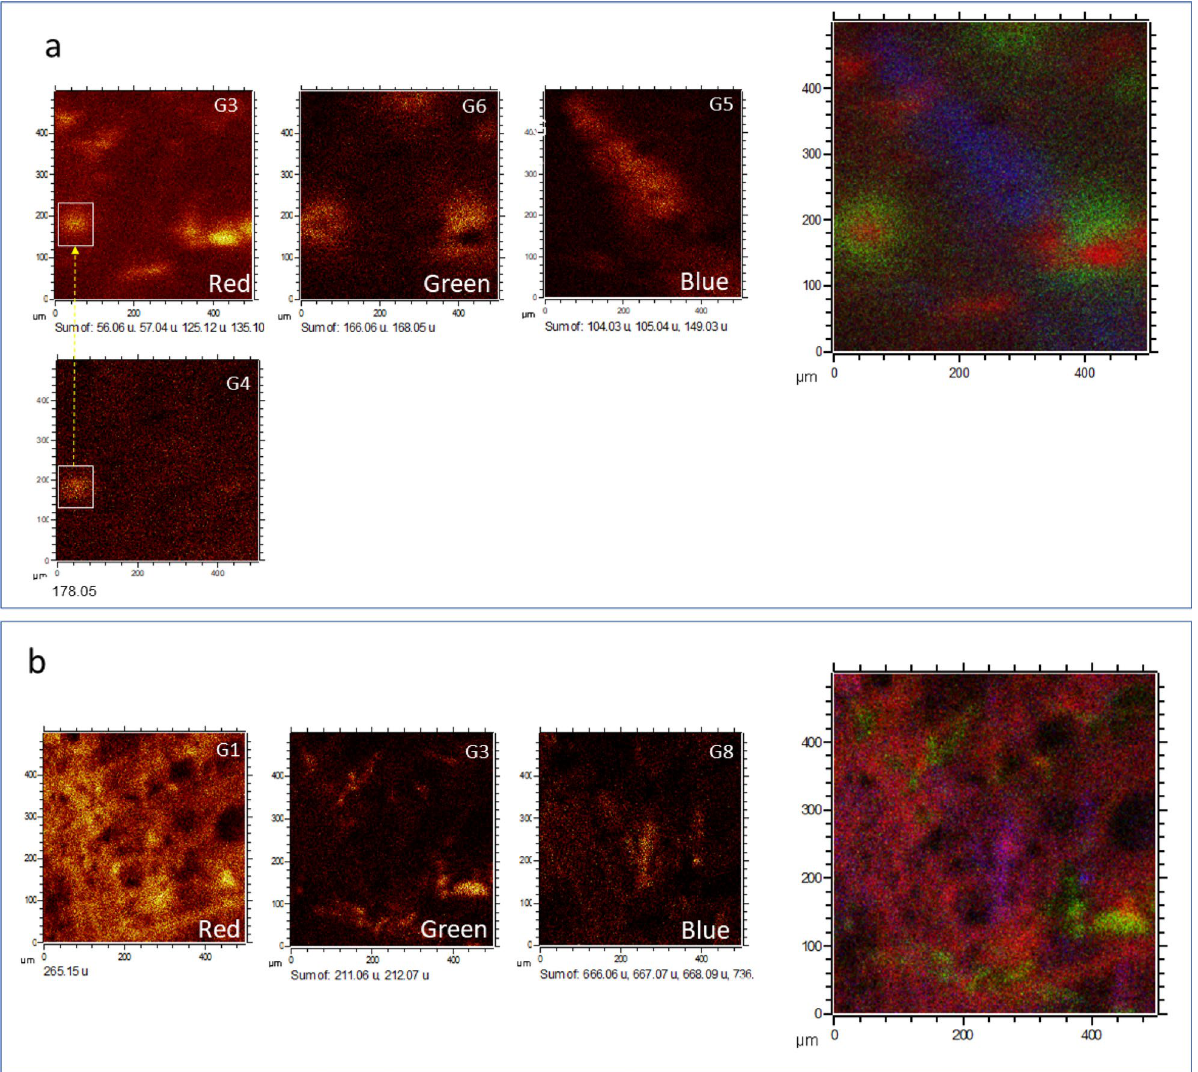
Figure 5. Couple of ToF–SIMS red/green/blue (RGB) overlays for ( a ) G3, G6 and G5 and ( b ) G1, G3, and G8 resulting in two different microstructure associations. The first RGB association ( a ) could correspond to compositional variations in plants (G5, G6, and G3) or to plant fragments (G5, and G6) affected by microbial activity (G3). Interestingly, G4 appears as a compositional variation in the G3 structure. The second RGB association ( b ) could include three different groups, namely, G1, G3 and G8 that could correspond to a microbial structure such as a biofilm in which the biomass is dominated by microbial forms biomineralizing sulfate. G3 structures interlock empty complementary areas in G1, suggesting that these areas could be the remains of different biological entities, while G8 branched microstructures merge with some filamentous units in G1, suggesting compositional variations in some specific zones of the filamentous mass of (Figs. S2–S4). By combining all the data sources retrieved via ToF–SIMS, the following morphological groups could be identified (Figs. 4, 5, 6, and 7). Group 1 This group is characterized by networks of < 50-micron-thick filaments (Figs. 4, 5, 6, and 7) show- ing strong mineralization by the enrichment in positive and negative sulfur-bearing ions such as Na 3 SO 4+ , K 2 NaSO 3+ , HS - , SO 2- , and SO 3- at 164.92, 196.86, 32.98, 63.96, and 79.96 (Figs. S2–S5), respectively, as well as different cations such as Fe + (55.94), K + (38.97), Na + (22.99) and Al + (26.98) (Figs. S2 to S5). TA1 filamentous structures are thicker and looser (Fig. 4) than filament networks found in TA2, which are thinner, overlap more tightly, and show 20-micron nodular ends (Fig. 6). In TA3, the distribution of positive and negative ions outlines an elliptic microstructure that is perpendicular to straight laminar projections (Fig. 7). Group 1 shows maximum intensities in different molecular groups, including a series of N-bearing compounds (e.g., m/z peaks at 268.30 and 282.31 corresponding to C 18 H 38 N + and C 19 H 40 N + ) and NH 4+ -bearing positive adducts found at 296.33, 494.56, 522.59 and 550.62 fitting C 20 H 42 N + , C 34 H 72 N + , C 36 H 76 N + , and C 38 H 80 N + , respectively. This group is also followed by a series of negative ions identified as fatty acids and/or ester carboxylates (e.g., m/z 197.15, 199.17, 227.20, or 255.23, corresponding to C 12 H 21 O 2- , C 12 H 23 O 2- , C 14 H 27 O 2- , or C 16 H 31 O 2- , respectively) and